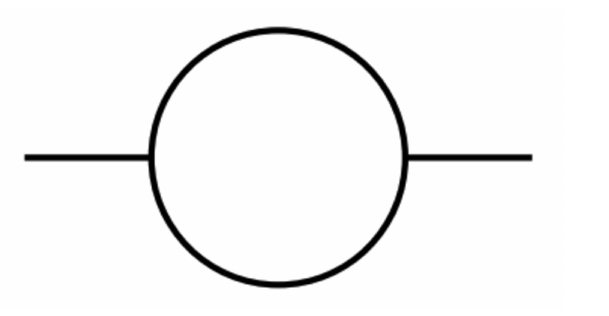
Figure 2 . Subleading